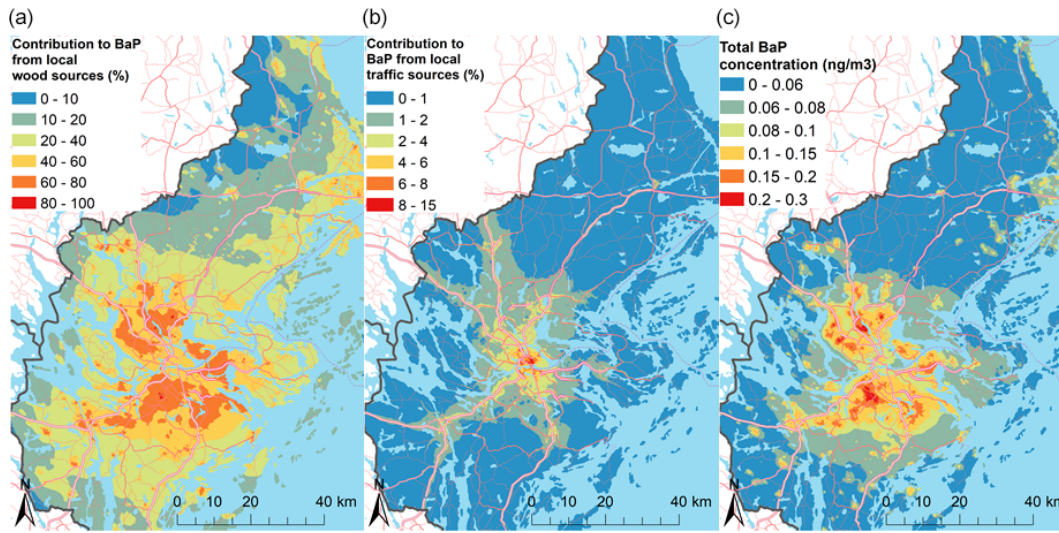
Figure 11. Modelled contribution to B[ a ]P from (a) local residential wood burning and (b) traffic in Stockholm County for a normal meteo- rological year and (c) modelled total B[ a ]P concentration in Stockholm County for a normal meteorological year with regional background data from 2014–2018. Red lines show road net and dark grey lines show the border of the